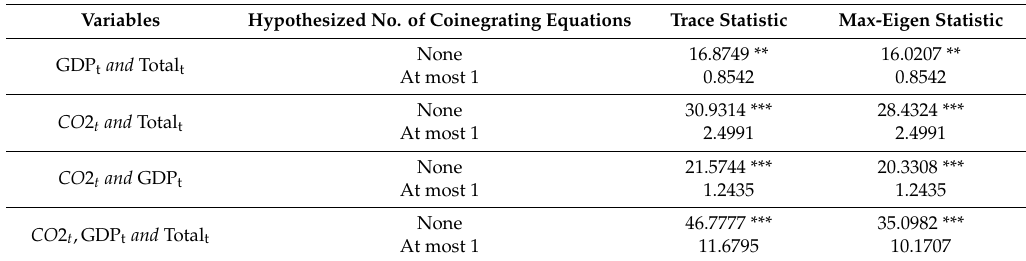
Table 3. Johansen Cointegration Test for GDP t , Total t , and CO 2 t .